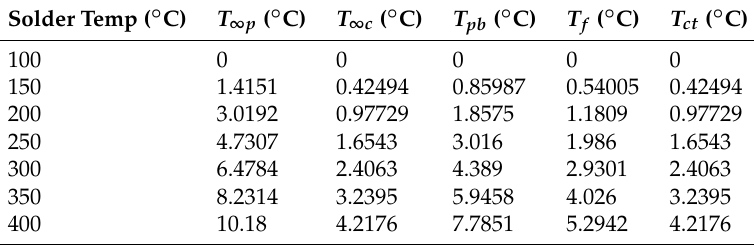
Table 1. Recorded temperature increase with appended